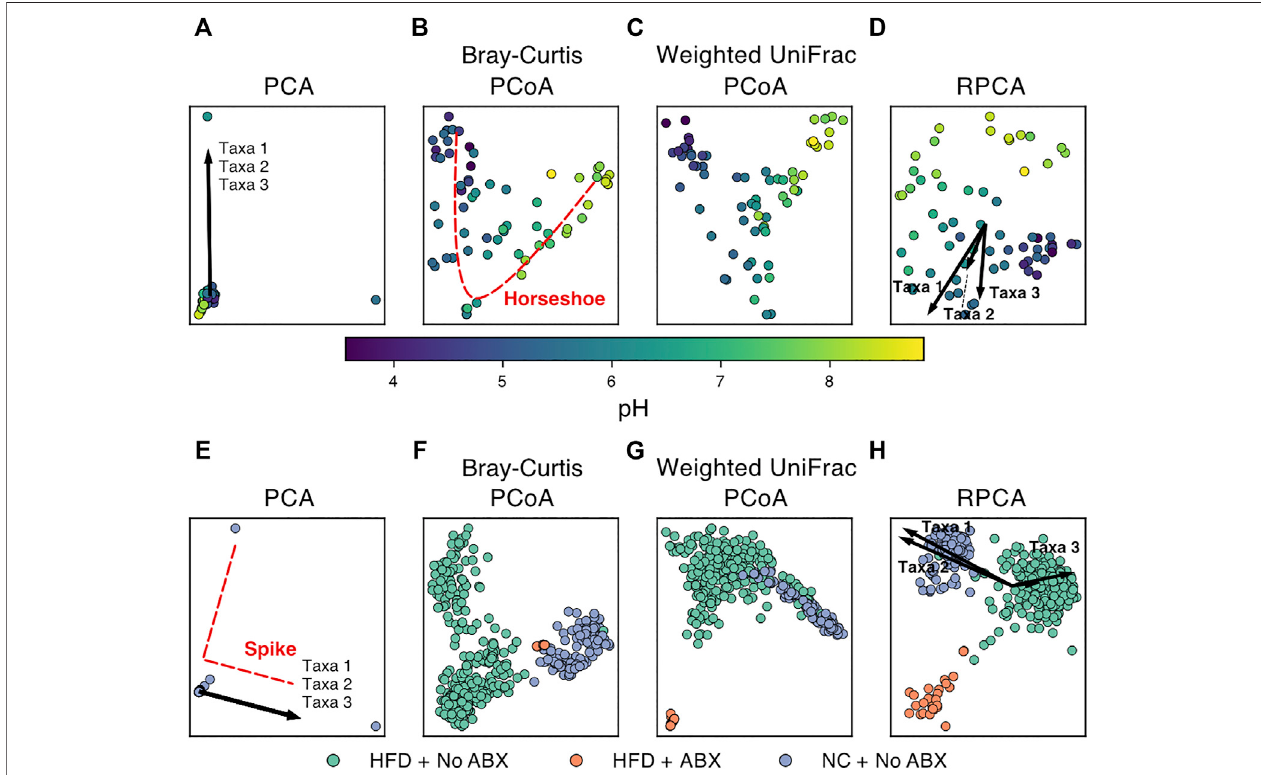
FIGURE2| Examplesofdimensionalityreductiontechniquesappliedtopubliclyavailablemicrobiomedata.(Top)Beta-diversityplotsofsoilsamplescoloredbypH from (Lauber et al., 2009). (Bottom) Beta-diversity plots of murine fecal samples colored by diet and antibiotics usage from (Shalapour et al., 2017). (HFD = high-fat diet, NC =normalchow,ABX=antibiotics).PCAplots (A,E) showextremelyhighsampleoverlapduetooutliersand characteristic “ spike ” artifacts.Thetopthreetaxa driving variationalsooverlapasshownbyarrowsuperposition. (B) “ Horseshoe ” patternemergesforsamplesfollowingecologicalgradientssuchaspH.RPCAplots (D,H) show the top three taxa driving separation of groups. (F) and (G) show strong overlap of HFD + ABX samples resolved by (H)